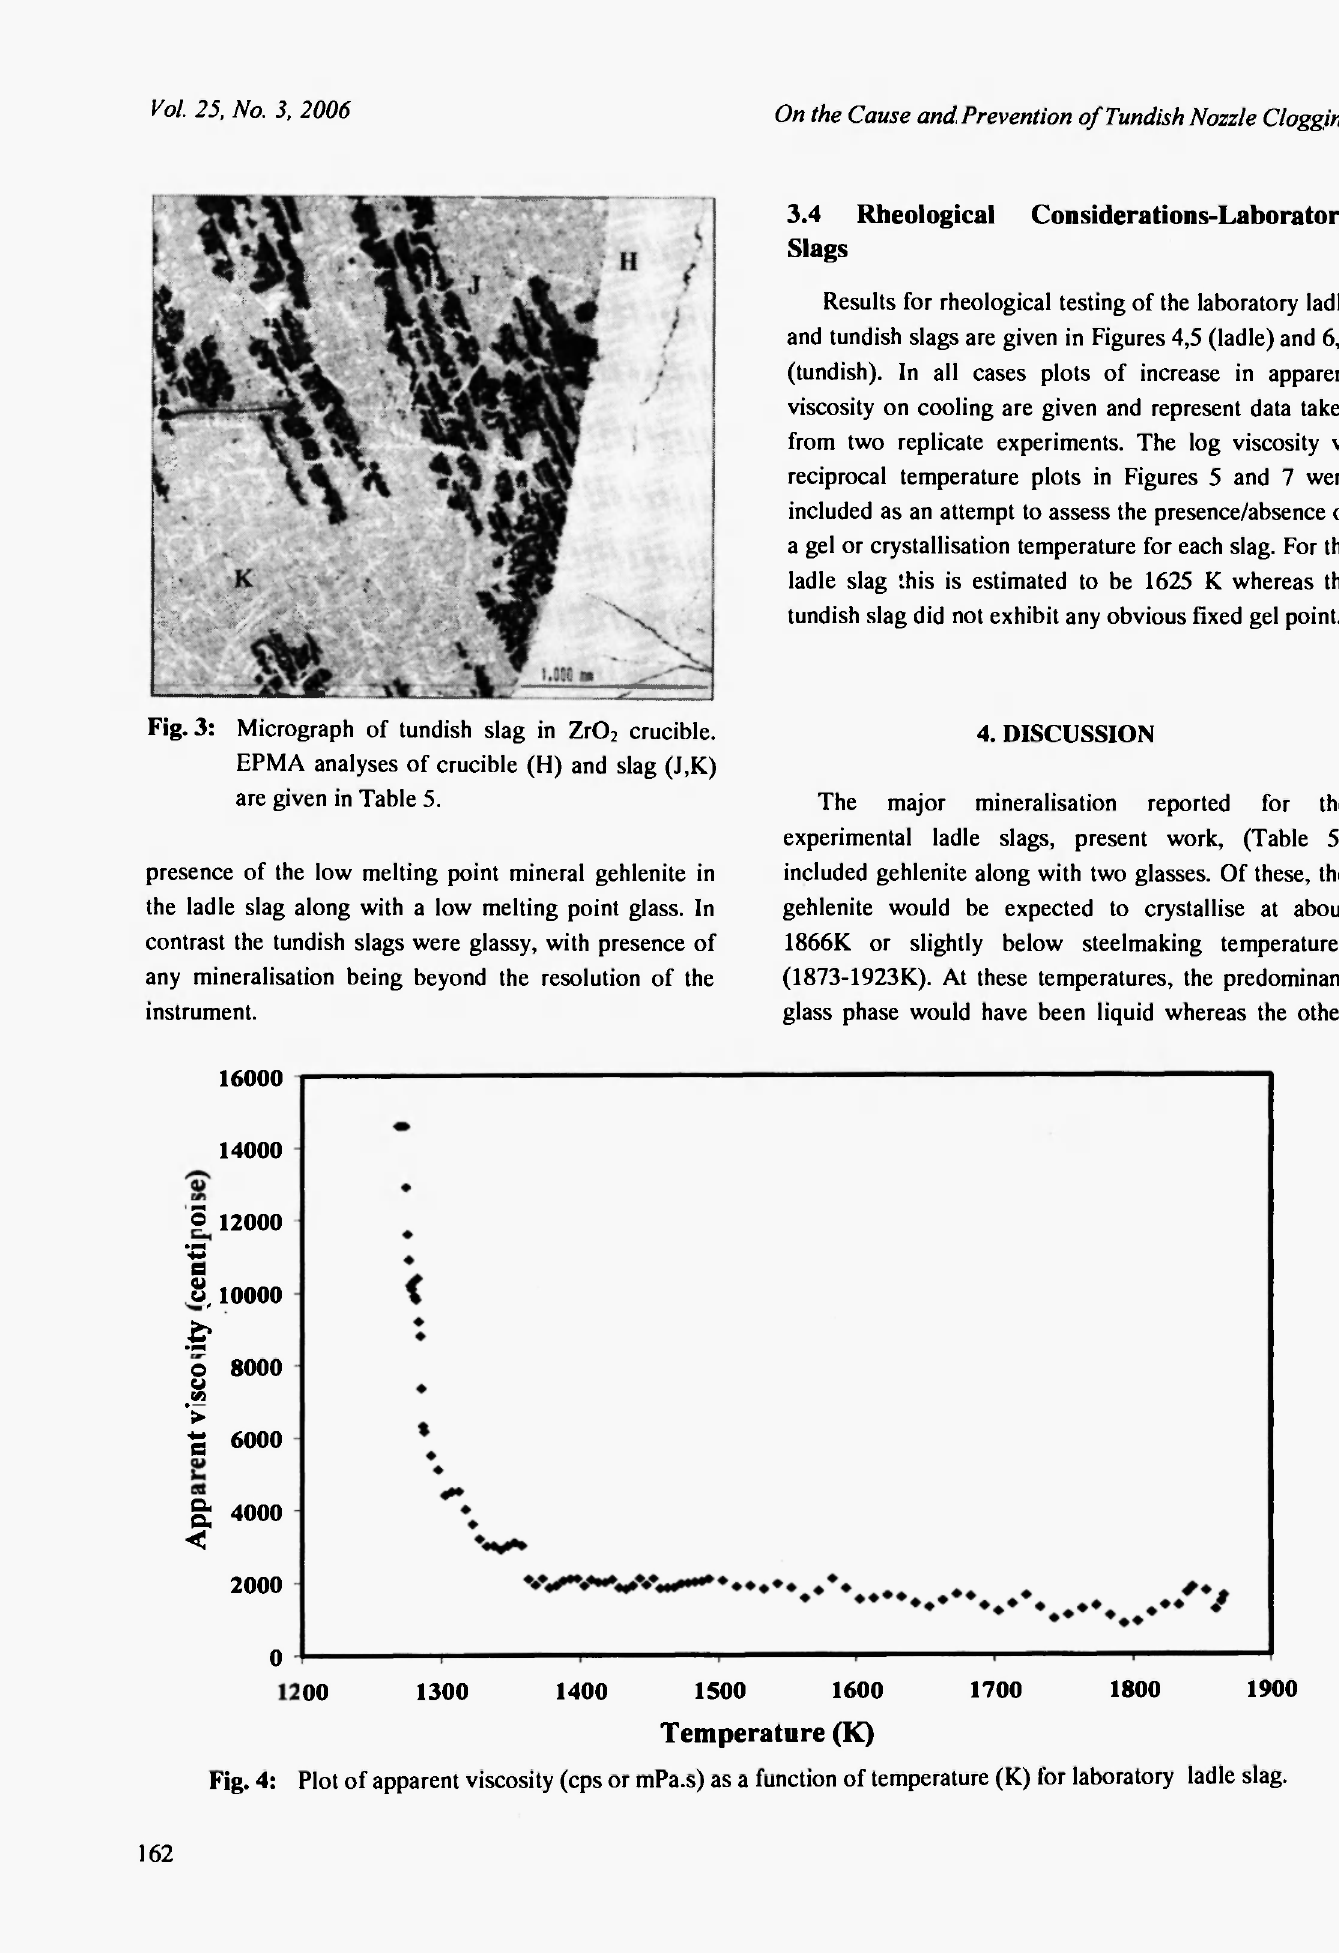
Fig. 3: Micrograph of tundish slag in Zr0 2 crucible. ΕΡΜΑ analyses of crucible (H) and slag (J,K) are given in Table 5.